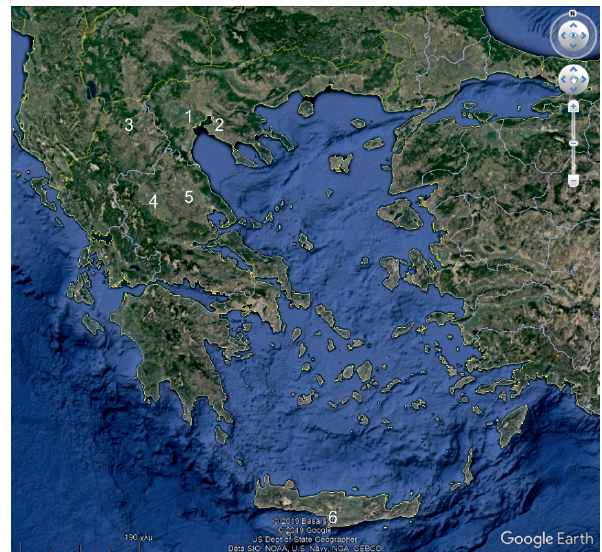
Figure 1. Location map of the major plain areas affected by the overexploitation of the aquifers. (1) Wider Kalochori – Sindos plain area, (2) Anthemountas basin, (3) Amyntaio basin, (4, 5) West and East Thessaly plain and (6) Messara basin. Base map from © Google Earth.